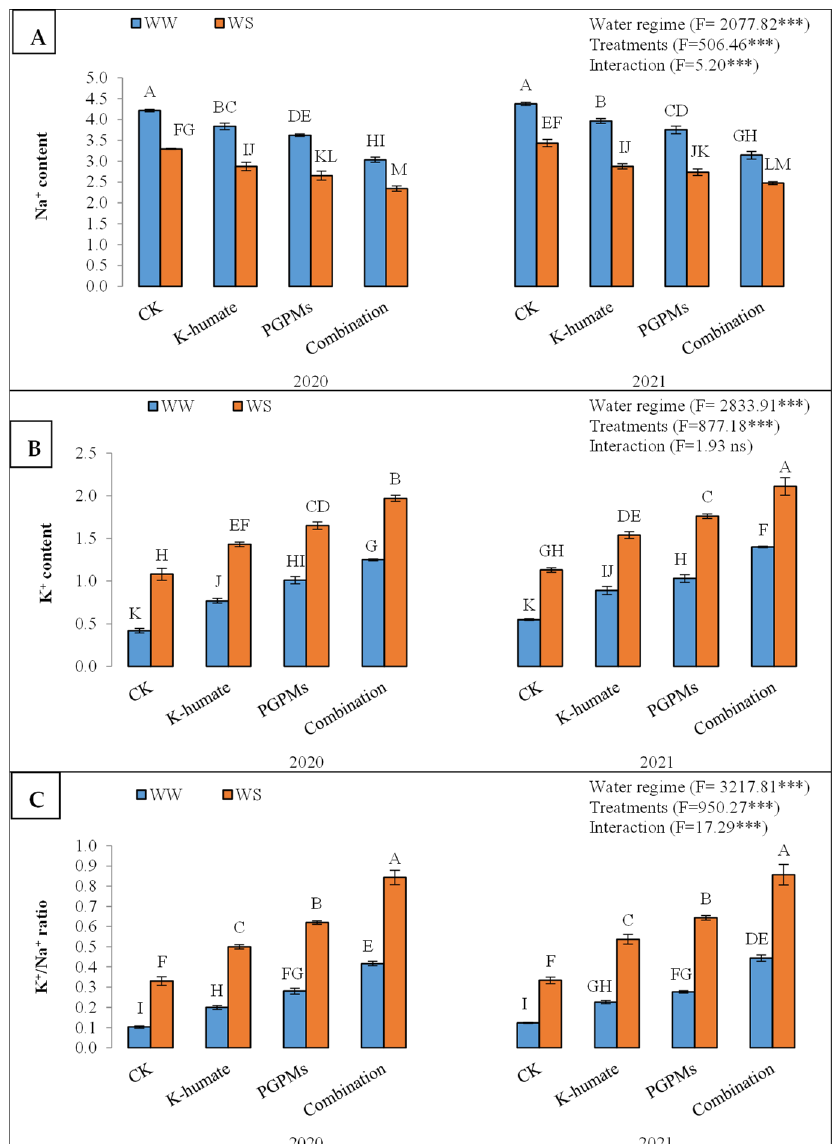
Figure 1. Uptake and accumulation of ( A ) Na + ; ( B ) K + ; and ( C ) K + /Na + in soybean seeds ( Glycine max L. cv. Giza 111) leaves, which was cultivated in salt-affected soil and treated with plant growth-promoting microbes (PGPMs, Bradyrhizobium japonicum (USDA 110), and Trichoderma harzianum ), potassium humate (K-humate), and their combination under two water regimes (WS: water deficit regime and WW: well-watered regime) during two consecutive seasons. Different letters above columns show significant differences between treatments according to the Tukey’s test ( p ≤ 0.05). Data are Means ± SD and n = 3. *** denotes significance at p ≤ 0.001, ns denotes insignificant difference.